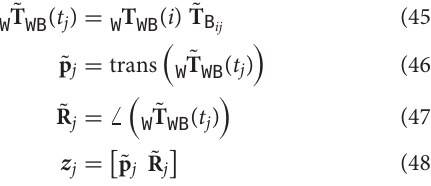
proportional to the true positive correspondences (i.e., the higher (cid:127) is, the larger the number of true positive matches and